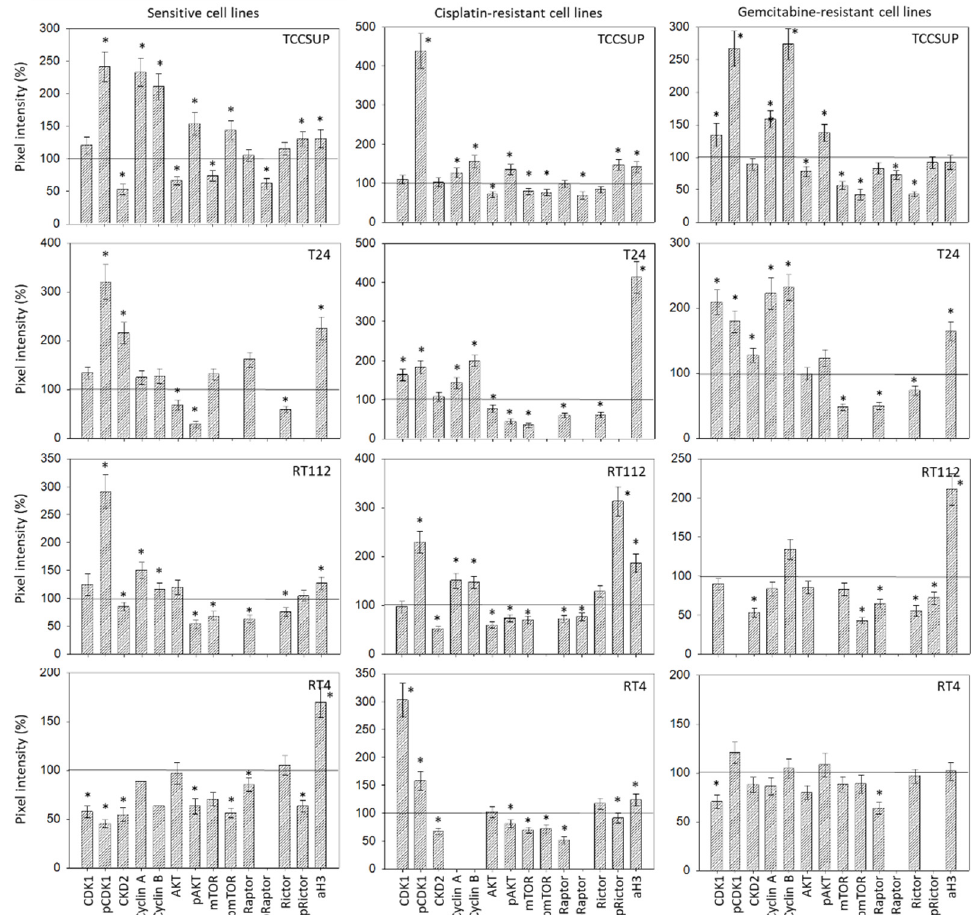
Figure 8. Pixel density analysis of the protein level in the sensitive and resistant bladder cancer cell lines following SFN treatment. Values are given in percentage, related to the 100% control (indicated by a black line). * indicates a significant difference compared to controls.